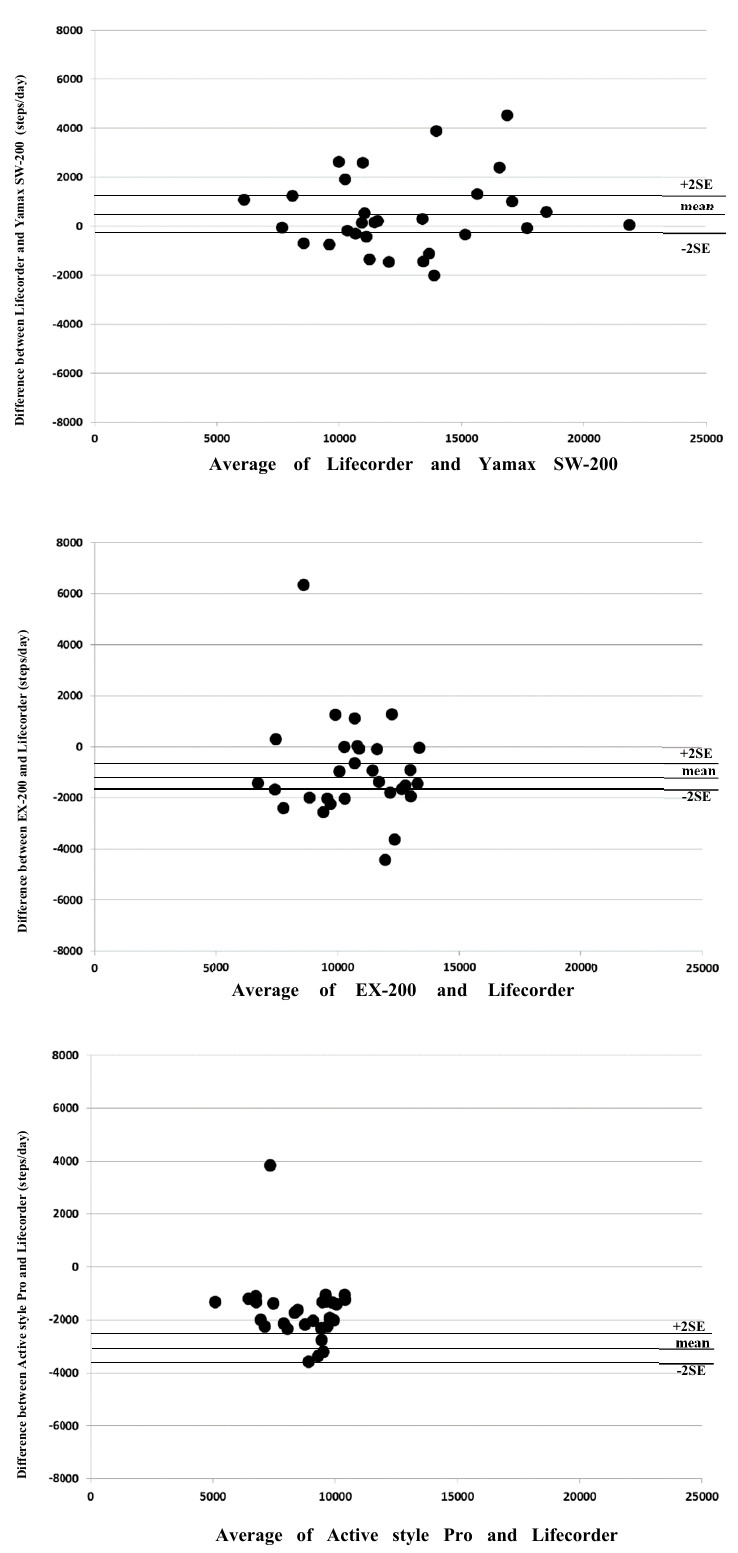
Figure 2. Bland—Altman plot showing the Lifecorder and each pedometer with the mean and the 95% confidence intervals for the